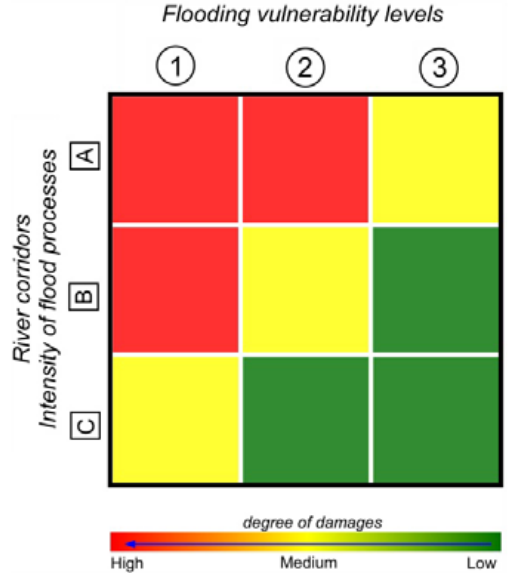
Fig. 10. A risk matrix with three different classes that identify the areas exposed to flooding: green (low degree of damage) to red (high degree of